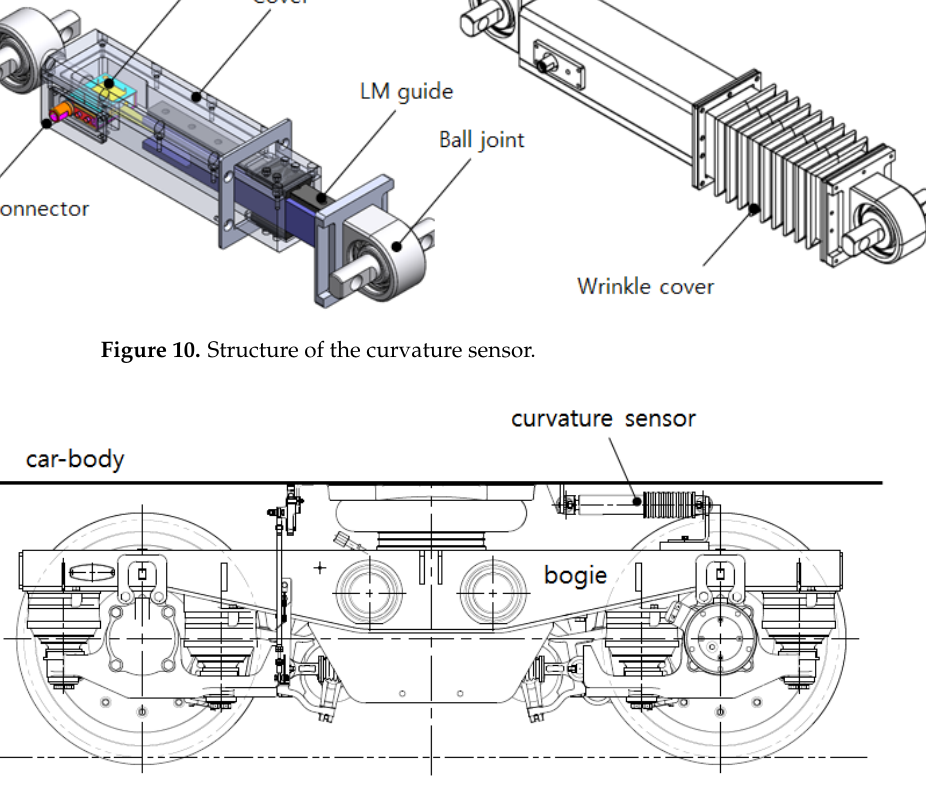
Figure 11. Installation position of the curvature sensor.